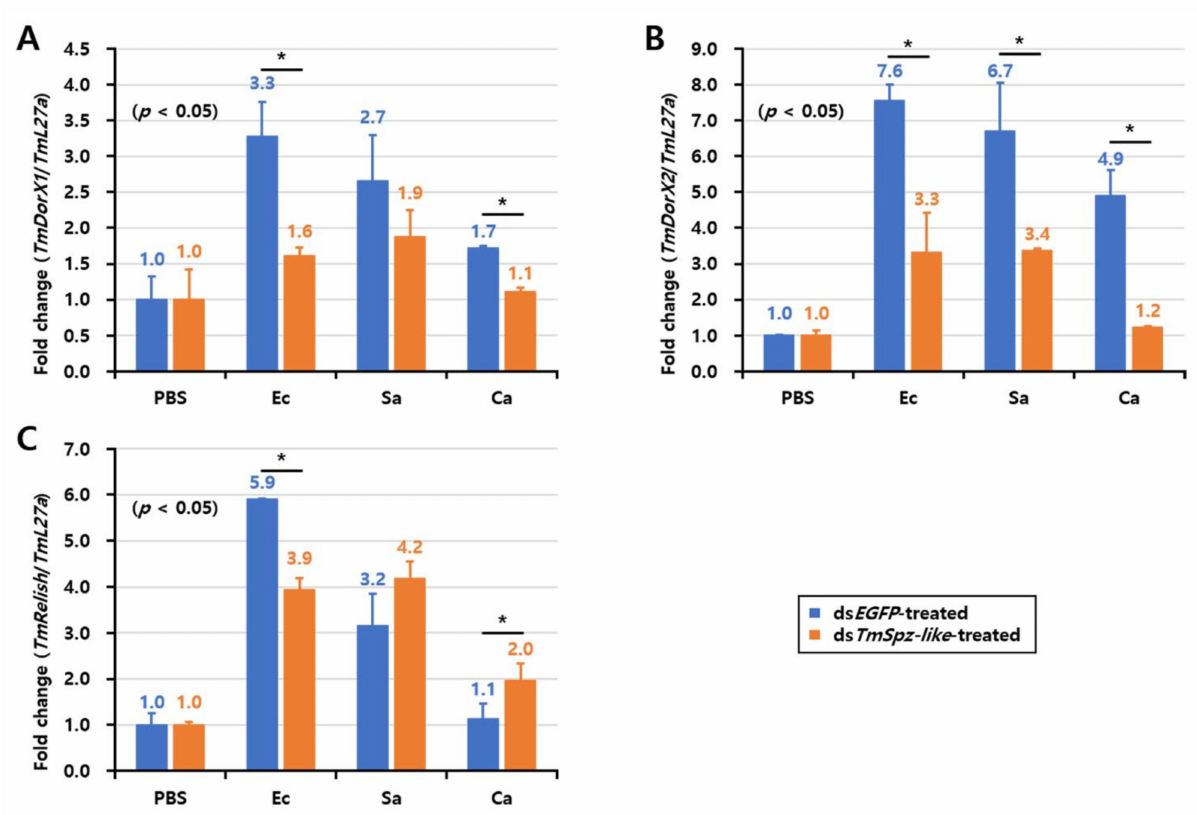
Figure 7. Effect of TmSpz-like knockdown on the expression of nuclear factor kappa B (NF- κ B)-encoding genes after challenge with Escherichia coli, Staphylococcus aureus , and Candida albicans . mRNA expression levels of TmDorX1 ( A ), TmDorX2 ( B ), and TmRelish ( C ) were investigated using quantitative real-time polymerase chain reaction. The negative control comprised ds EGFP -injected larvae. TmL27a expression was assessed as an internal control. All experiments were performed in triplicate. Asterisks indicate significant differences in NF- κ B-encoding gene expression between the ds TmSpz-like and ds EGFP- injected groups (Student’s t -test; * p <